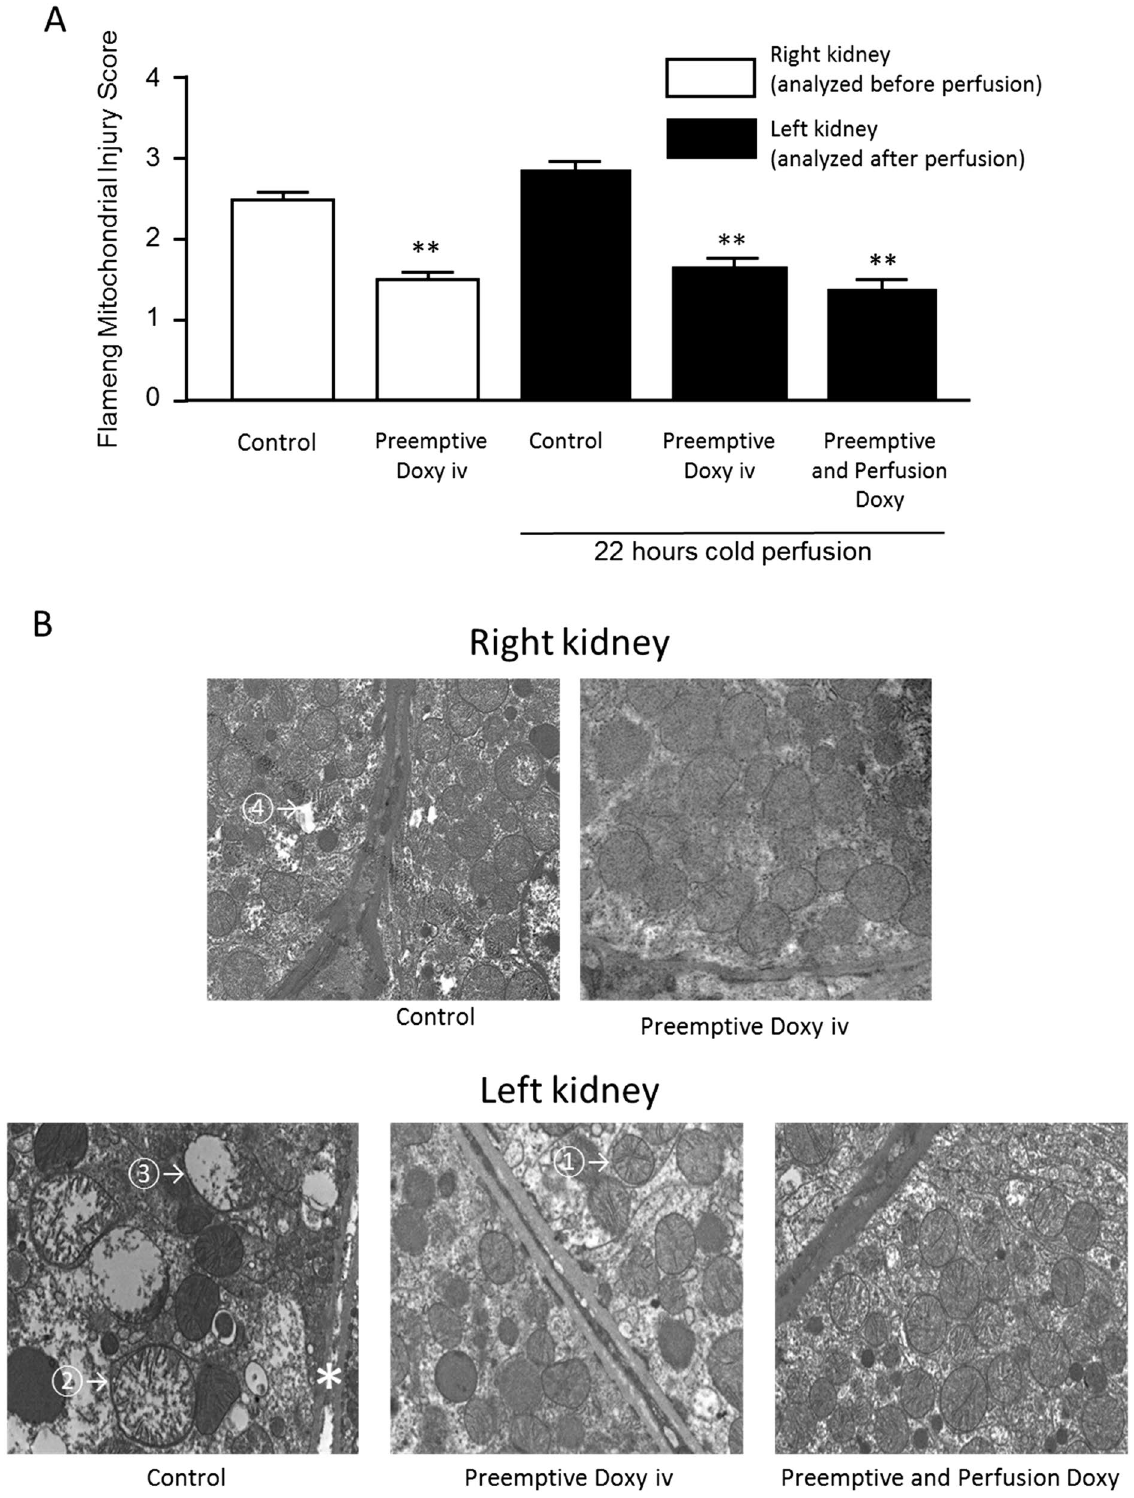
Figure 5. ( A ) Mitochondrial injury in Donation after Circulatory Death rat kidneys as measured by the Flameng Mitochondrial Injury Score. ** p < 0.01 compared to Control group, using the Mann–Whitney U test. ( B ) Representative electron micrographs of control and treatment group kidneys with examples of Flameng mitochondrial scoring (5000 × magnification). (1) Normal structure with granules absent. (2) Swollen mitochondria with clarification of the matrix. (3) Disruption of mitochondrial crests. (4) Loss of integrity of the mitochondrial inner and outer membrane. (*) Endothelial